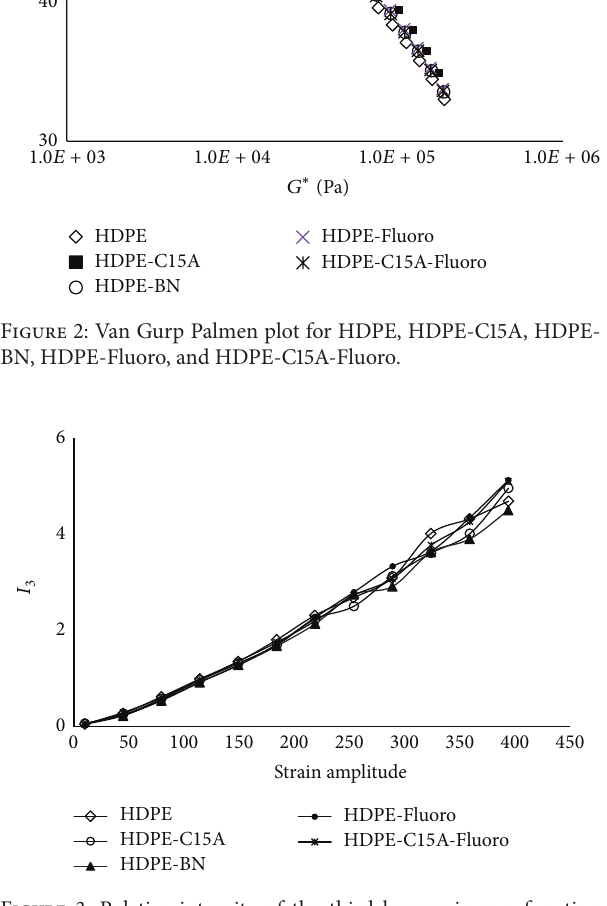
Figure 3: Relative intensity of the third harmonic as a function of strain amplitude at 200 ∘ C for HDPE, HDPE-C15A, HDPE-BN, HDPE-Fluoro, and HDPE-C15A-Fluoro.